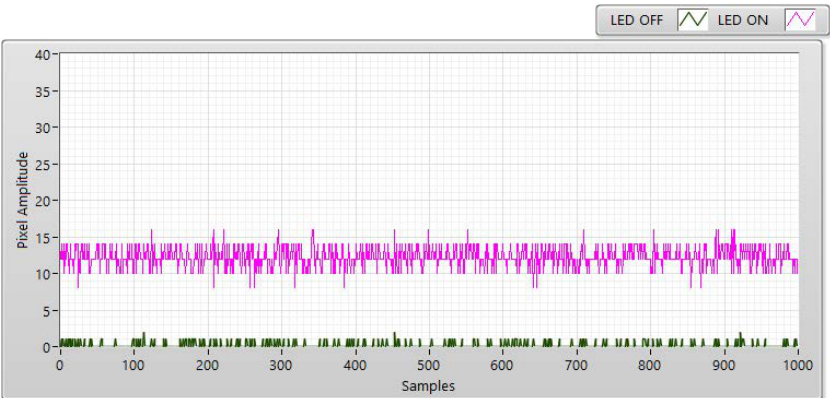
Figure 7. SNR measurement with a Point Grey rolling shutter camera at a communication distance of 10 m with 100 µs.